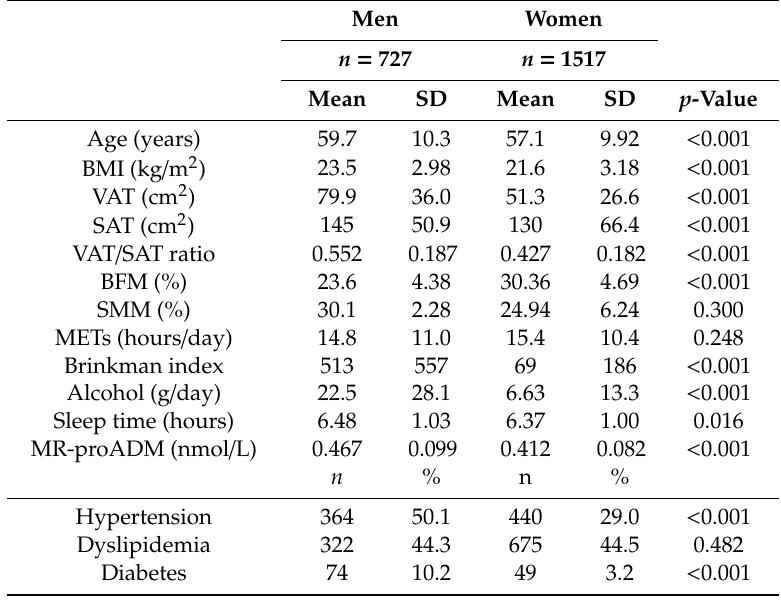
Table 1. Characteristics of participants according to